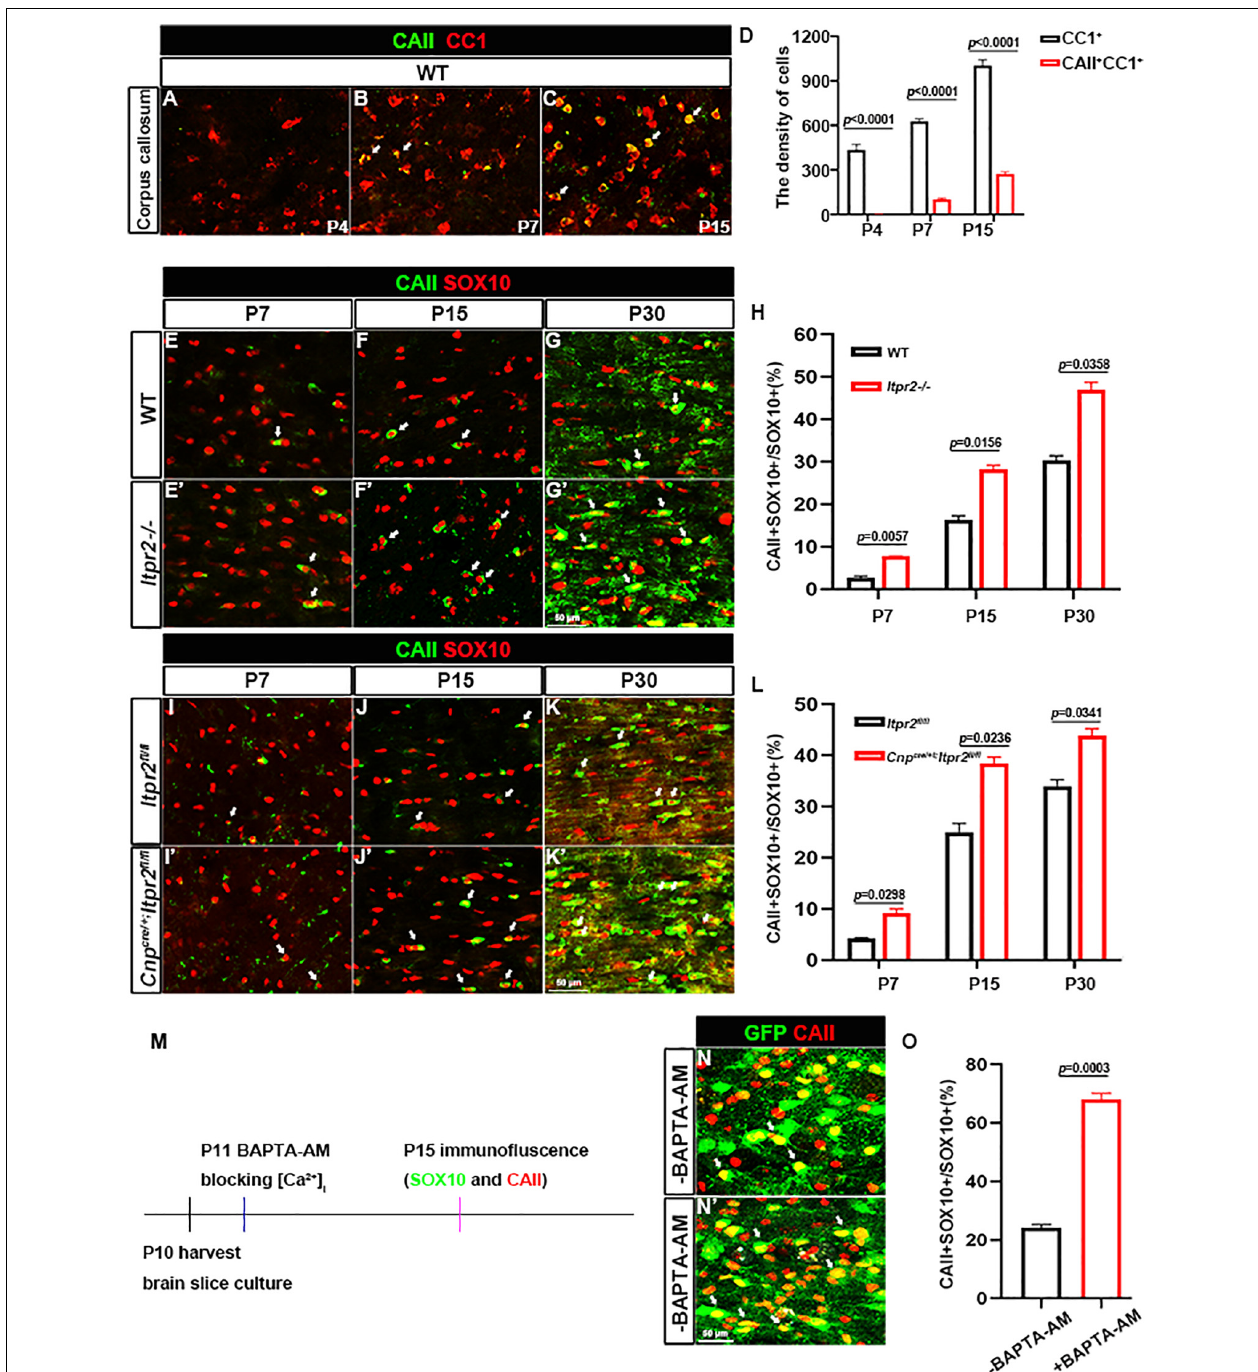
FIGURE 5 | Disruption of ITPR2 increases the proportion of type I/II oligodendrocytes. (A–C) Double immunostaining of CAII and CC1 in early postnatal brain tissues. (D) Quantification of the density of CC1 positive cells and CAII/CC1 double positive cells in the corpus callosum of wild-type mice. (E–G (cid:48) ) Immunofluorescent images of CAII and SOX10 staining in corpus callosum tissues from various stages of WT and Itpr2-/ mice. Double positive cells are represented by white arrows. (H) Quantitative analysis of the ratio of CAII + cells in SOX10 + oligodendrocytes at indicated stages. (I–K (cid:48) ) CAII and SOX10 double-immunostaining in corpus callosum tissues from various stages of control and Cnp cre / + ; Itpr2 fl / fl mice. Double positive cells are represented by white arrows. Scale bar represents 50 µ m. (L) Quantitative analysis of the percentage of CAII + cells in SOX10 + oligodendrocytes at indicated stages. (M) Schematic of workflow of organotypic slice cultures. (N,N (cid:48) ) Immunostaining of CAII in the corpus callosum of cultured Sox10-GFP slices. Compared with the control groups, the ratio of CAII + SOX10 + oligodendrocytes remarkably increased in the corpus callosum of cultured slices treated with 20 µ M BAPTA-AM. Scale bar represents 50 µ m. (O) Quantification of the percentage of CAII/SOX10-GFP double positive cells in SOX10-GFP + population in brain slice culture from (N,N (cid:48) ) . Error bar indicates Means ± SEM. n ≥ 3.